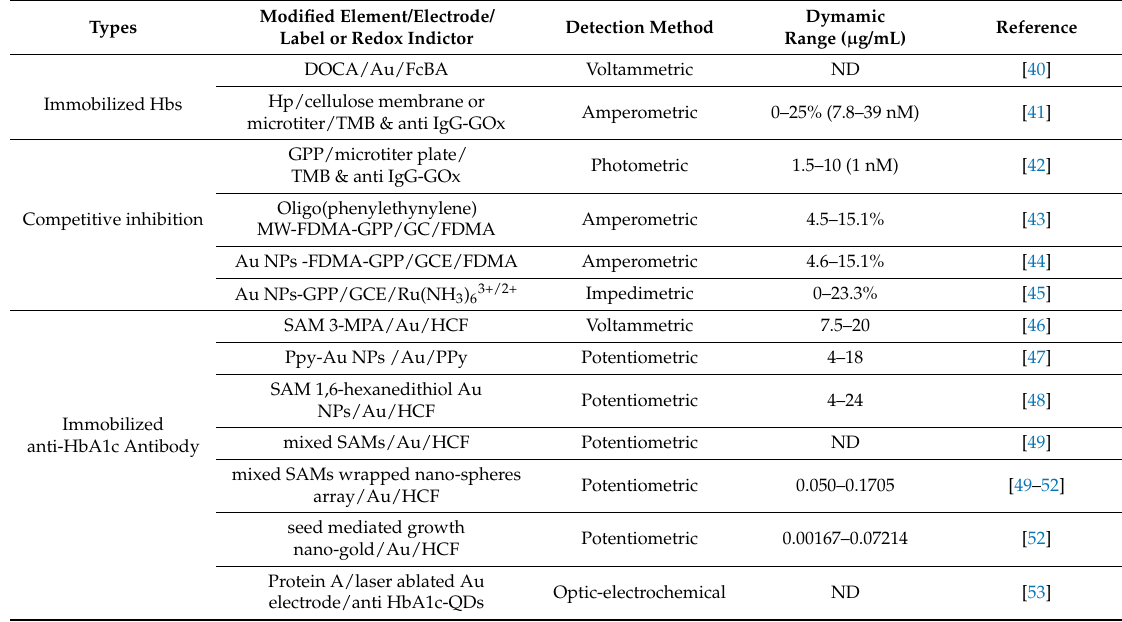
Table 3. Comparison of HbA1c immunosensors based on recognition methods.